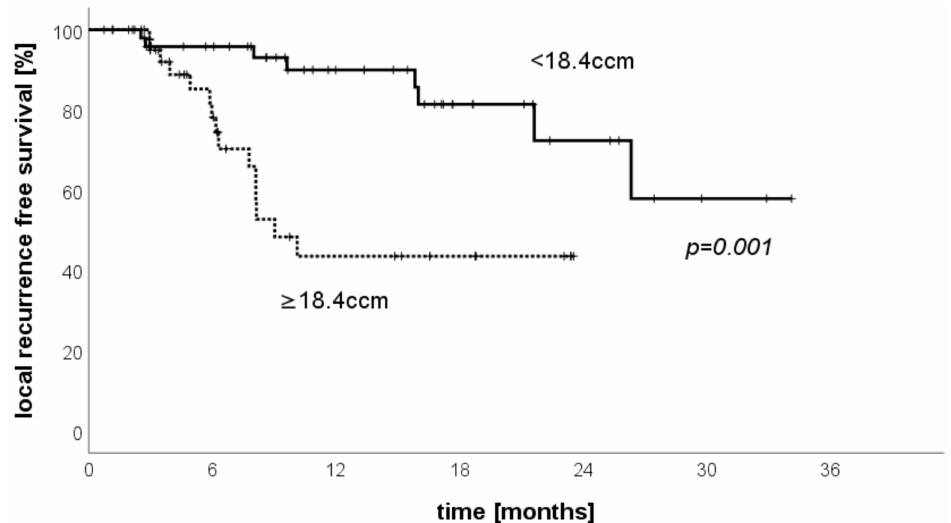
Figure 4. Local-recurrence-free survival stratified by total treated